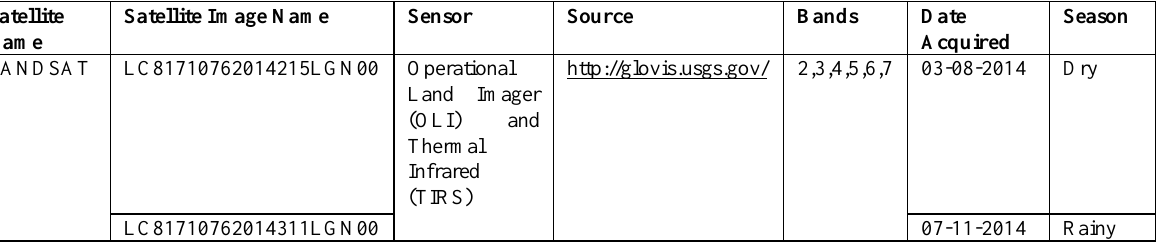
Table 1: Details about 30 m spatial resolution LANDSAT 8 image data used in the